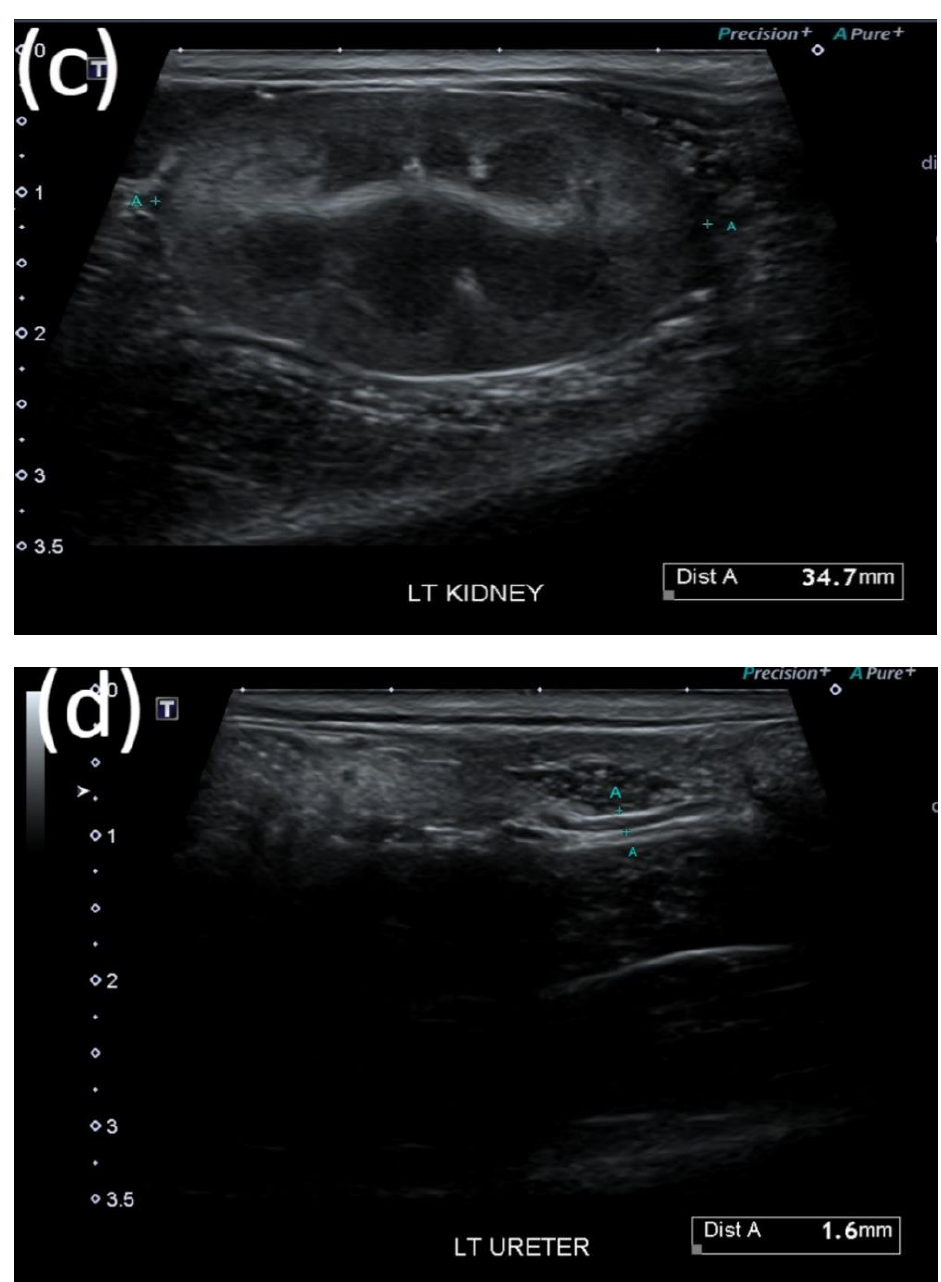
Figure 1. Representative ultrasound image of successful stone passage in a cat. ( a ) Dilated renal pelvis owing to obstruction and ( b ) high-contrast material presumed to be a stone in the distal part of the ureter. ( c , d ) After tamsulosin therapy, improved renal pelvic dilation and successful stone passage were confirmed through ultrasound imaging.